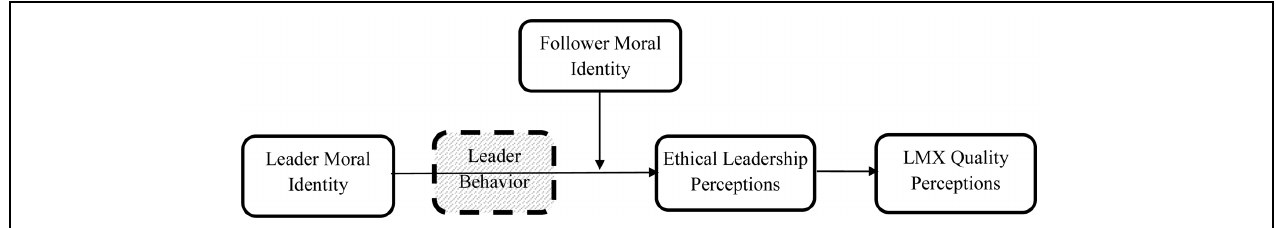
FIGURE 1 | Moderated mediation model. The dotted box represents an unmeasured explanatory mechanism.